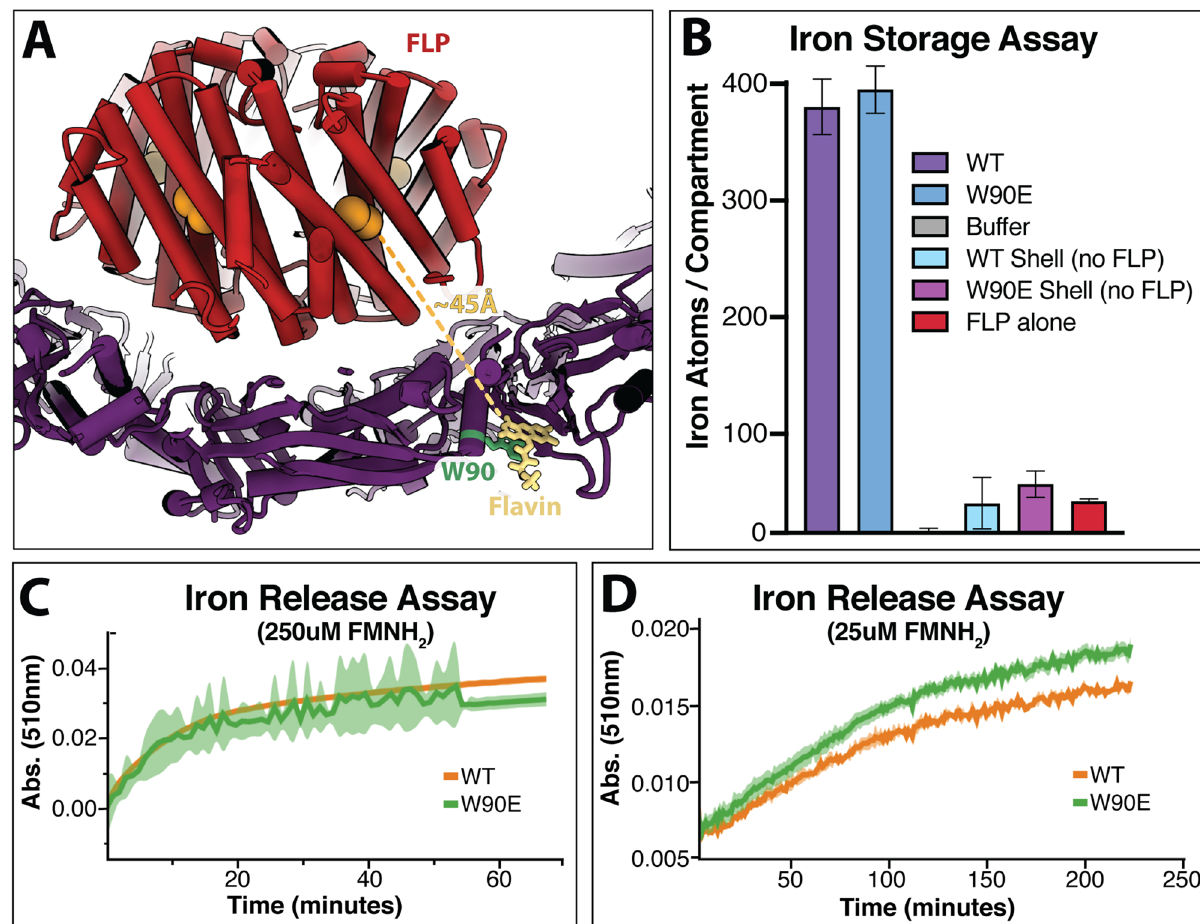
Figure 5. Biochemical data regarding the role of flavin in iron mineralization and iron mobilization. ( A ) Depiction of the distance between the FLP active site and the FMN molecule bound to the shell, with FLP in red, the active site in orange, the shell in purple, the bound FMN in yellow, and the interacting W90 residue in green. ( B ) shows the ferroxidase iron storage activity of various encapsulin constructs. ‘WT’ is the unmodified encapsulin with FLP cargo protein; ‘W90E’ also contains the FLP cargo protein but also represents the W90E mutation to the shell; ‘WT Shell’ does not contain the FLP cargo; ‘W90E Shell’ is also lacking the FLP and contains the W90E mutation; and ‘FLP alone’ represents the FLP cargo protein free in solution that was purified without the encapsulin shell. The opposite activity, the release of iron, is shown in ( C ) at 250uM FMNH 2 and ( D ) at 25 uM FMNH 2 . FLP-loaded encapsulin constructs with a ferric oxide core were used for the experiments in ( C ) and ( D ), with the green curve representing W90E-encapsulin without flavin, and the orange trace is WT FLP-encapsulin. ( C ) and ( D ) lines represent n = 3 average, with the envelope showing standard